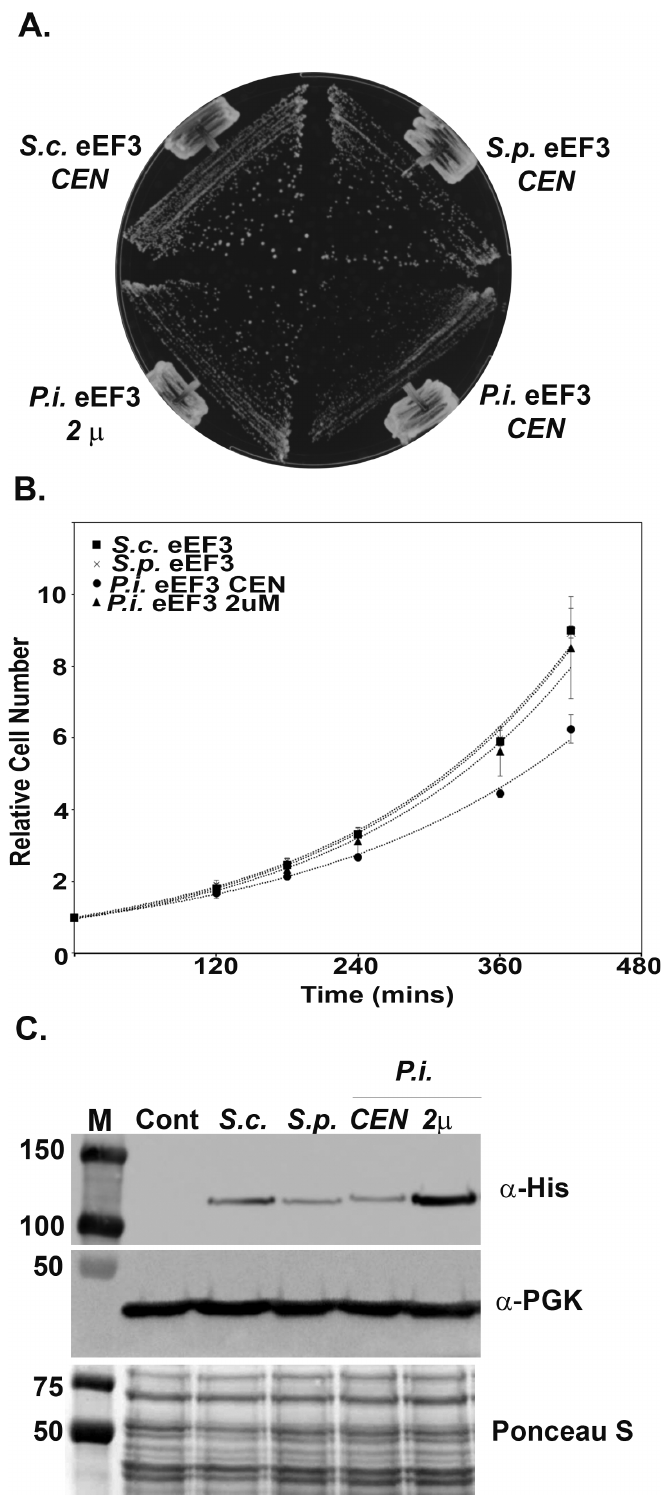
Fig 1. S . pombe (S . p . ) and P . infestans (P . i . ) eEF3 complement the loss of S . cerevisiae(S . c . ) eEF3. (A) Yeast strains expressingeEF3 from the indicatedspecies as the only form of eEF3 were streaked onto YEPD medium and incubatedat 30˚C for 2 d. CEN–lowcopy numberplasmid/low expression. 2 μ –high copy